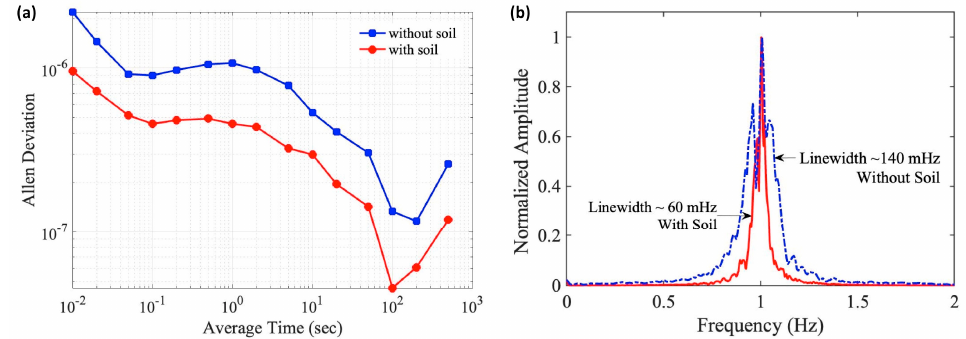
Figure 3. ( a ) The Allan deviations of the 50-MHz beat note from the MZ–FP interferometer with (circle) and without (square) the soil insulation. ( b ) The linewidths of the beat note (down–shifted to 1 Hz) with and without the soil insulation.